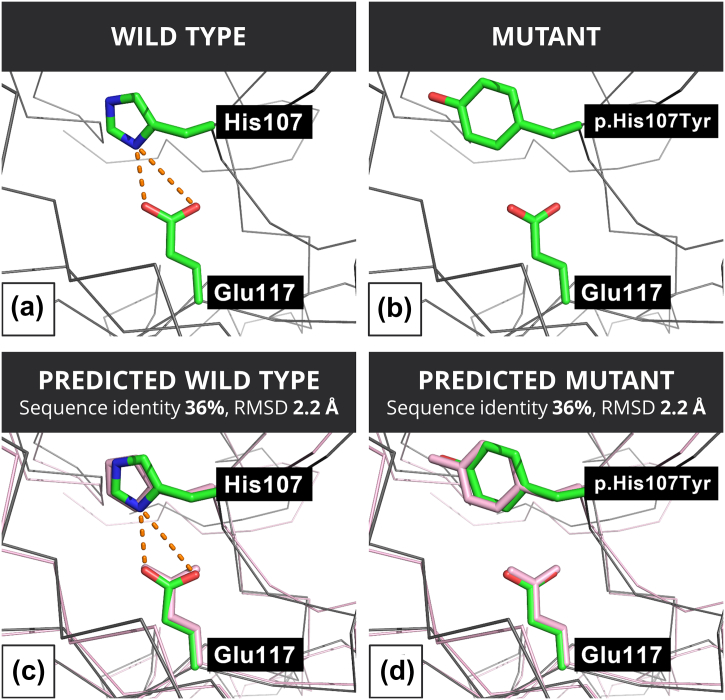
Structural analysis of p.His107Tyr in the experimental and predicted structures of carbonic anhydrase (CA2). (a) His 107 in the wild-type (WT) (PDB ID: 2FOS), (b) Tyr 107 in the mutant (MUTANT) modeled from the WT, (c) Phyre2-predicted structure of the wild type with His 107 (PREDICTED WILD TYPE) and (d) predicted structure of the Tyr 107 mutant based on the Phyre2-predicted wild-type structure (PREDICTED MUTANT). In all four panels, the Cα traces of the structures analyzed by Missense3D are shown in gray. In the predicted structures (c and d), the Cα trace and side-chain positions shown in panels a and b are shown in pink. The side chains of the His 107, Tyr 107 and Glu 117 are show by chemical type (green for non-polar, blue for positive and red for negative). Figures were generated using PyMOL [54].